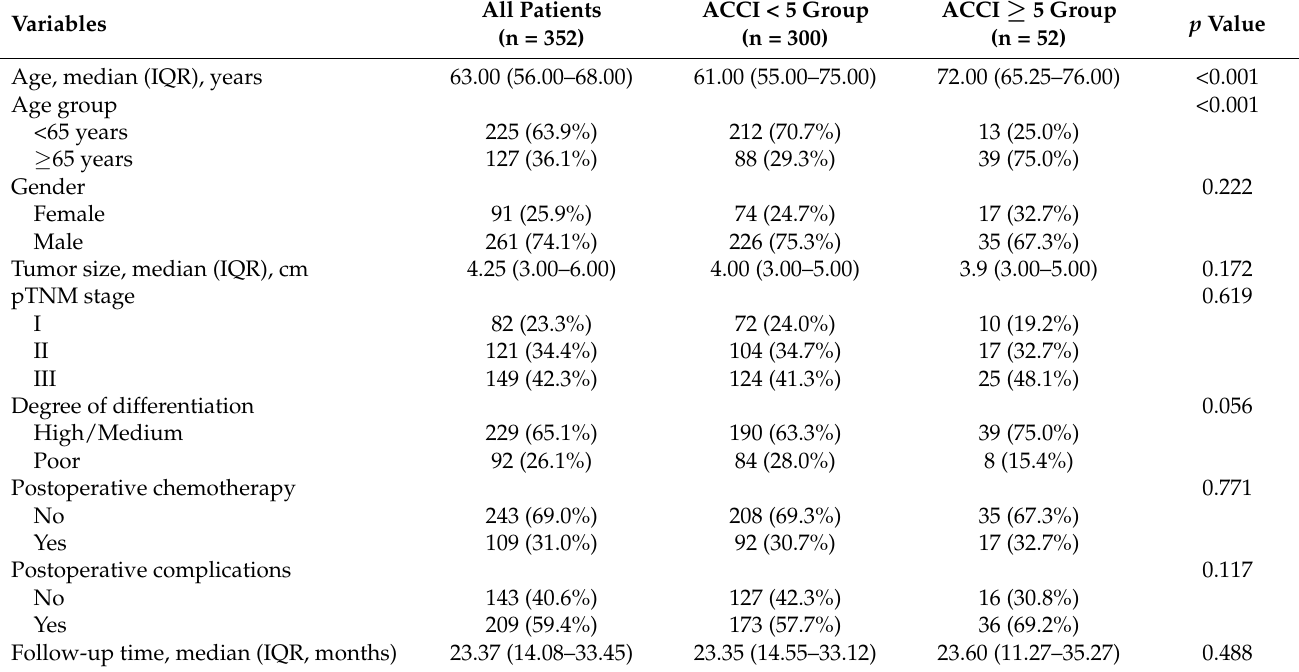
Table 2. Comparison of the clinical variables between esophageal cancer patients in different ACCI